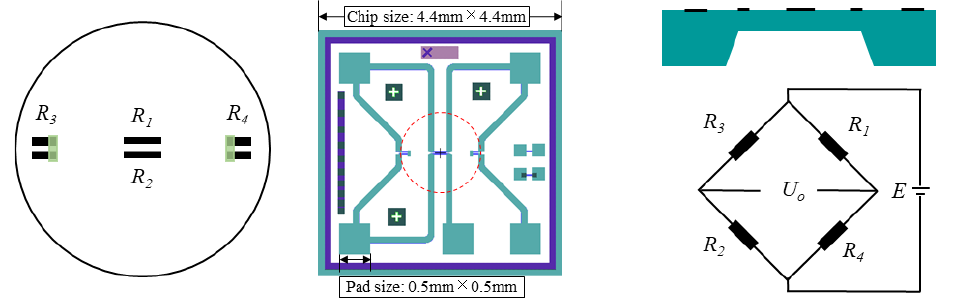
Figure 3. Structure of SiC pressure sensor and piezoresistor arrangement.